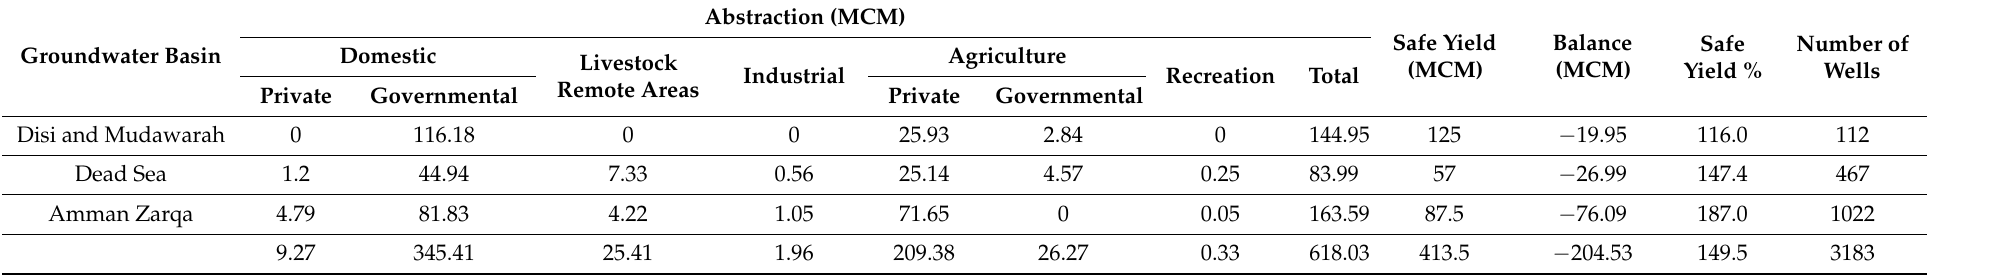
Table 4. Abstraction from groundwater basins in Jordan and their safe yields in 2019